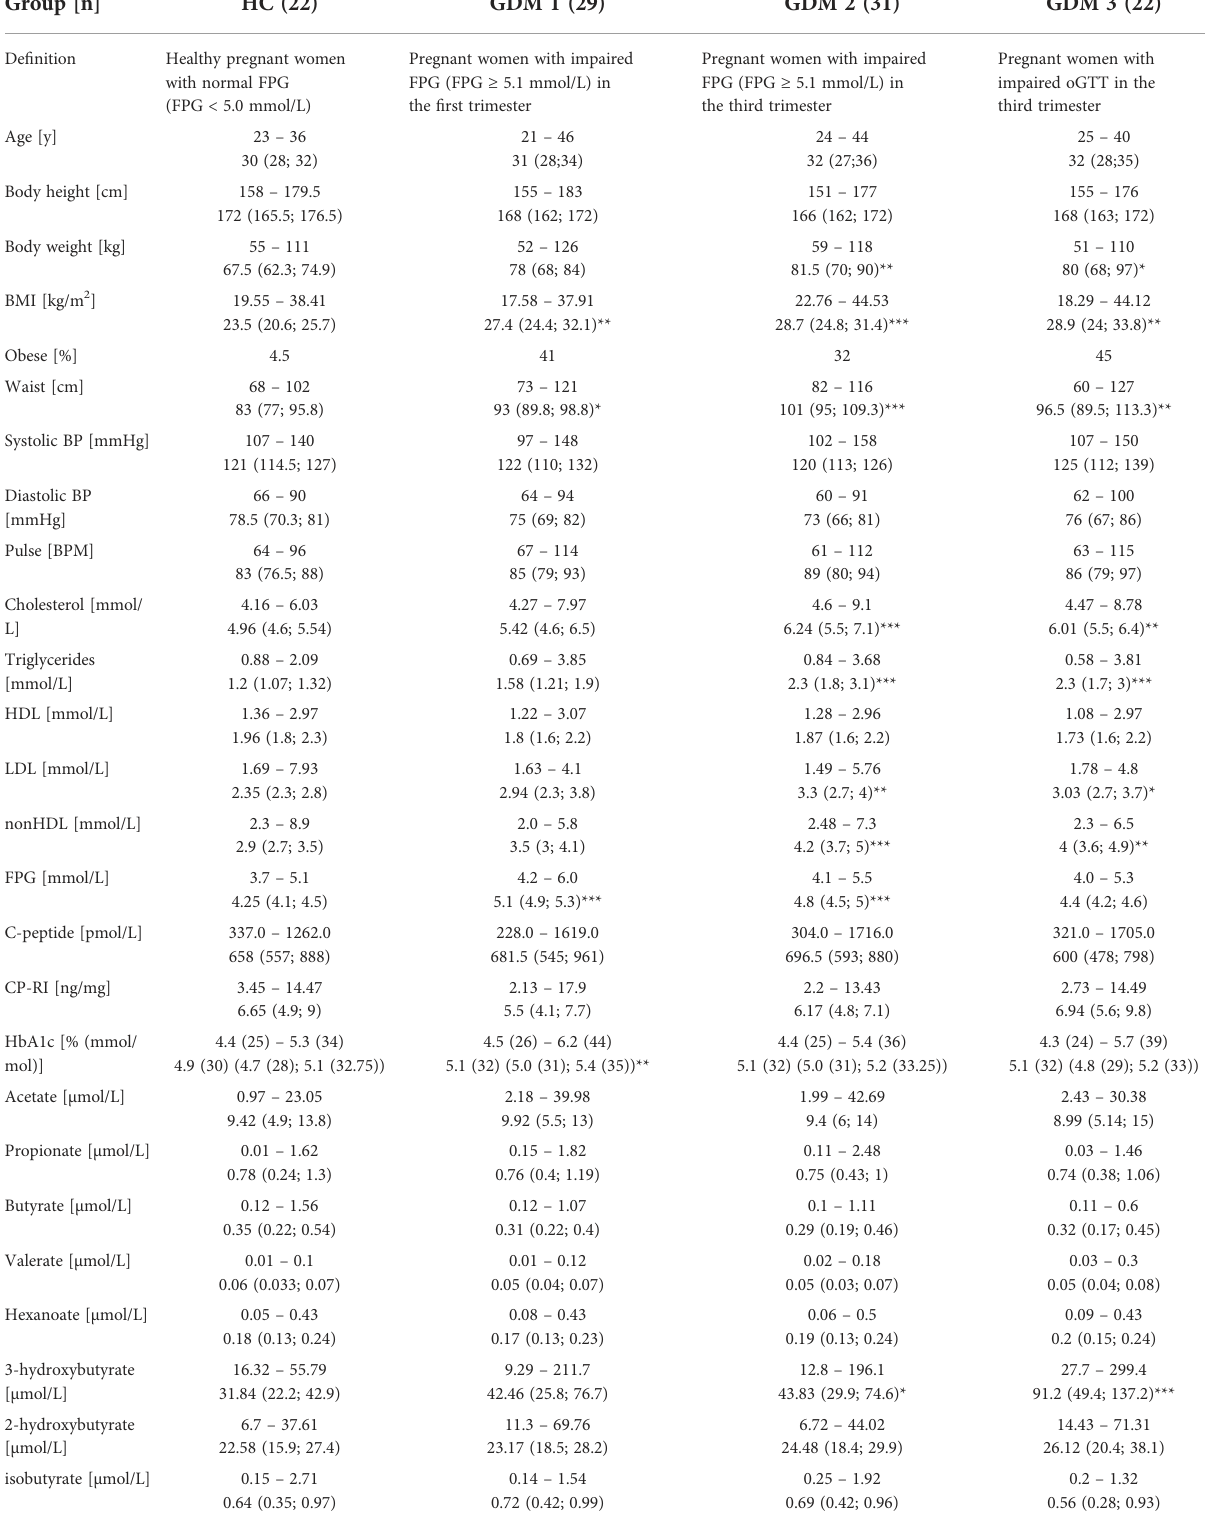
TABLE 1 First trimester clinical and biochemical data of healthy pregnant women and pregnant women with impaired FPG or